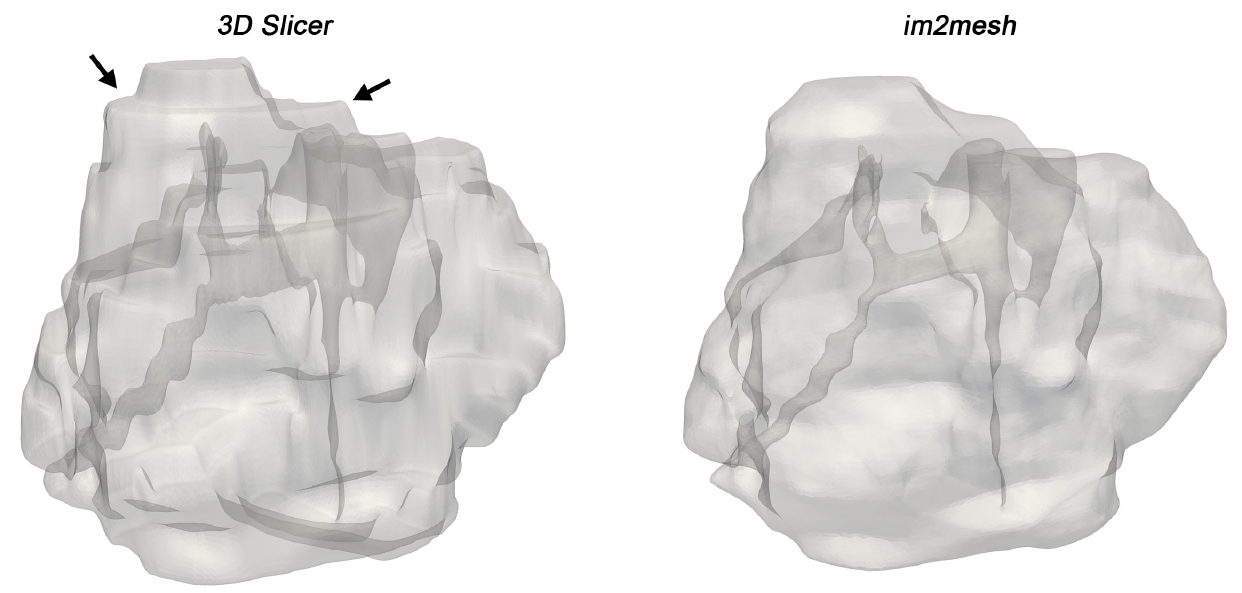
Figure A1. Neuroblastoma tumour reconstruction from 17 slices using 3D Slicer (default values, no filters applied) and im2mesh. Note that without any user intervention (i.e., mask correction, filter application) 3D Slicer produces a more staggered geometry (black arrows). This is due to the morphological contour interpolation algorithm used by the software which was developed to avoid over-smoothing and preserve the exact topological details of the geometry. This algorithm, therefore, works very well when the slice thickness is low (higher density of slices) but is less suitable when the number of slices is scarce, as is the case of most of the data available within the PRIMAGE dataset.